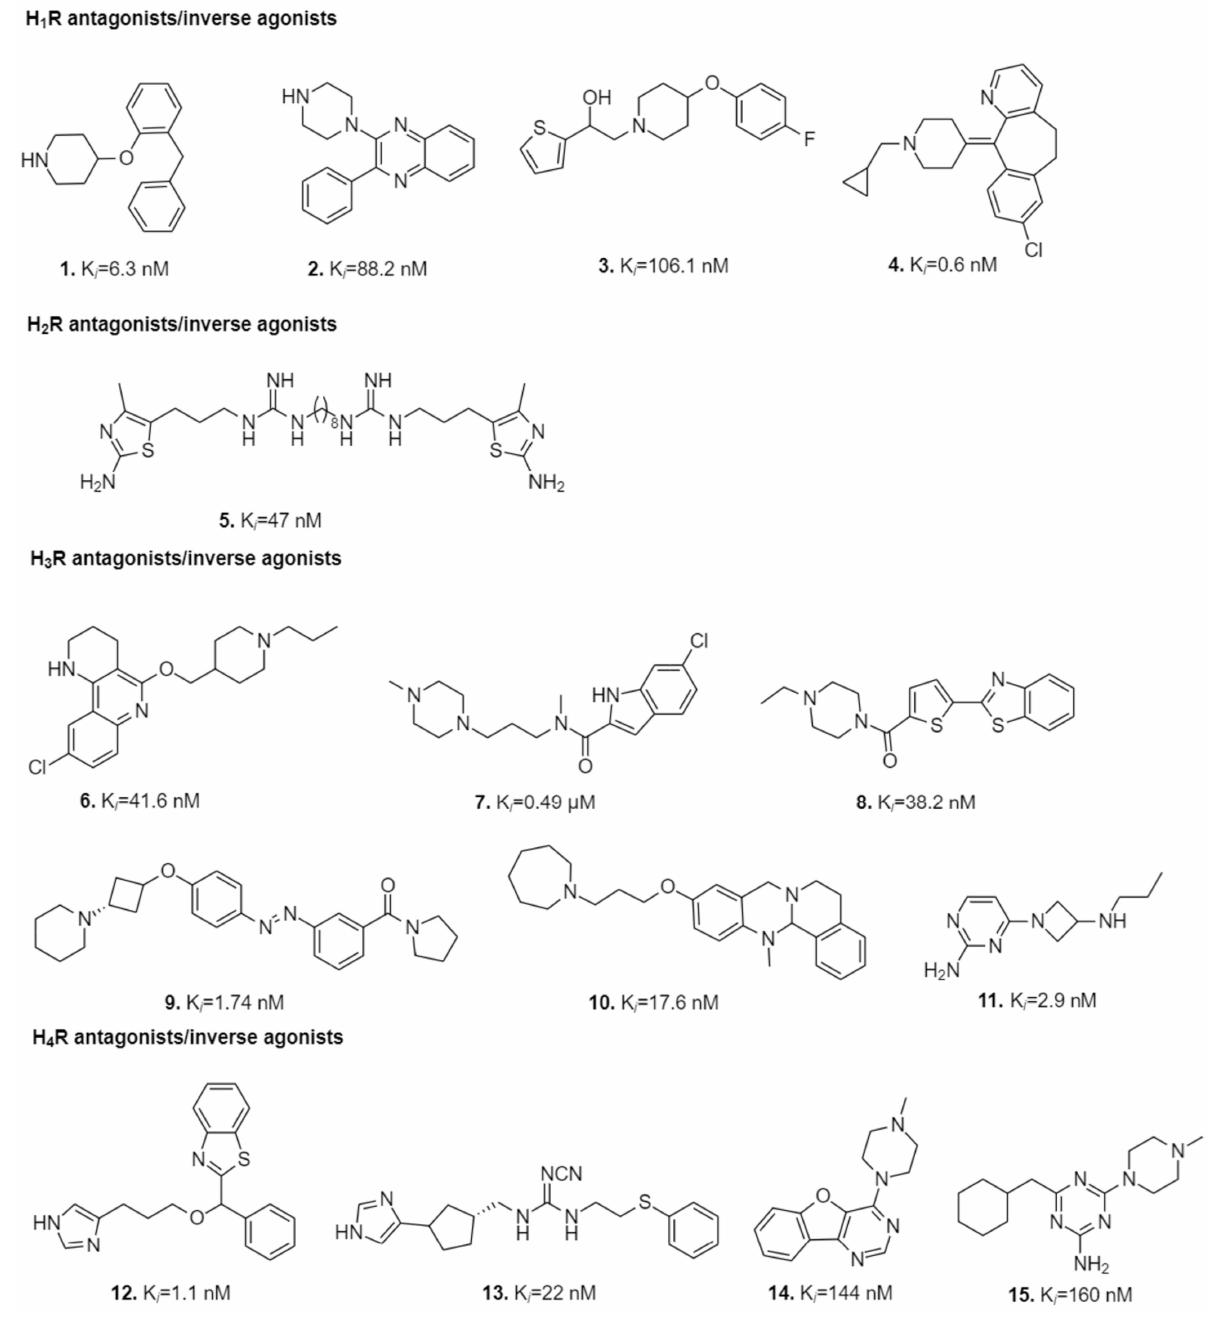
Figure 2. The most potent ligands targeting HRs discovered through diverse virtual screening and docking approaches in 2014–2020 and their biological